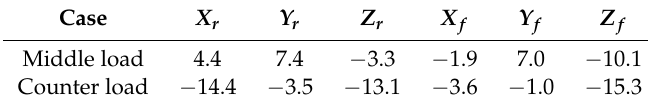
Table 2. Middle and counter loads: Percent displacement difference